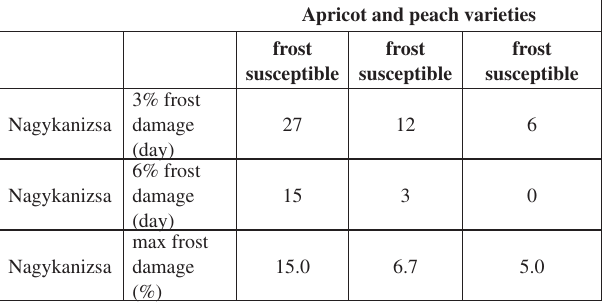
Table 3 – Occurrence of frost damage of increasing severity in apricot and peach varieties of different susceptibility during the rest period